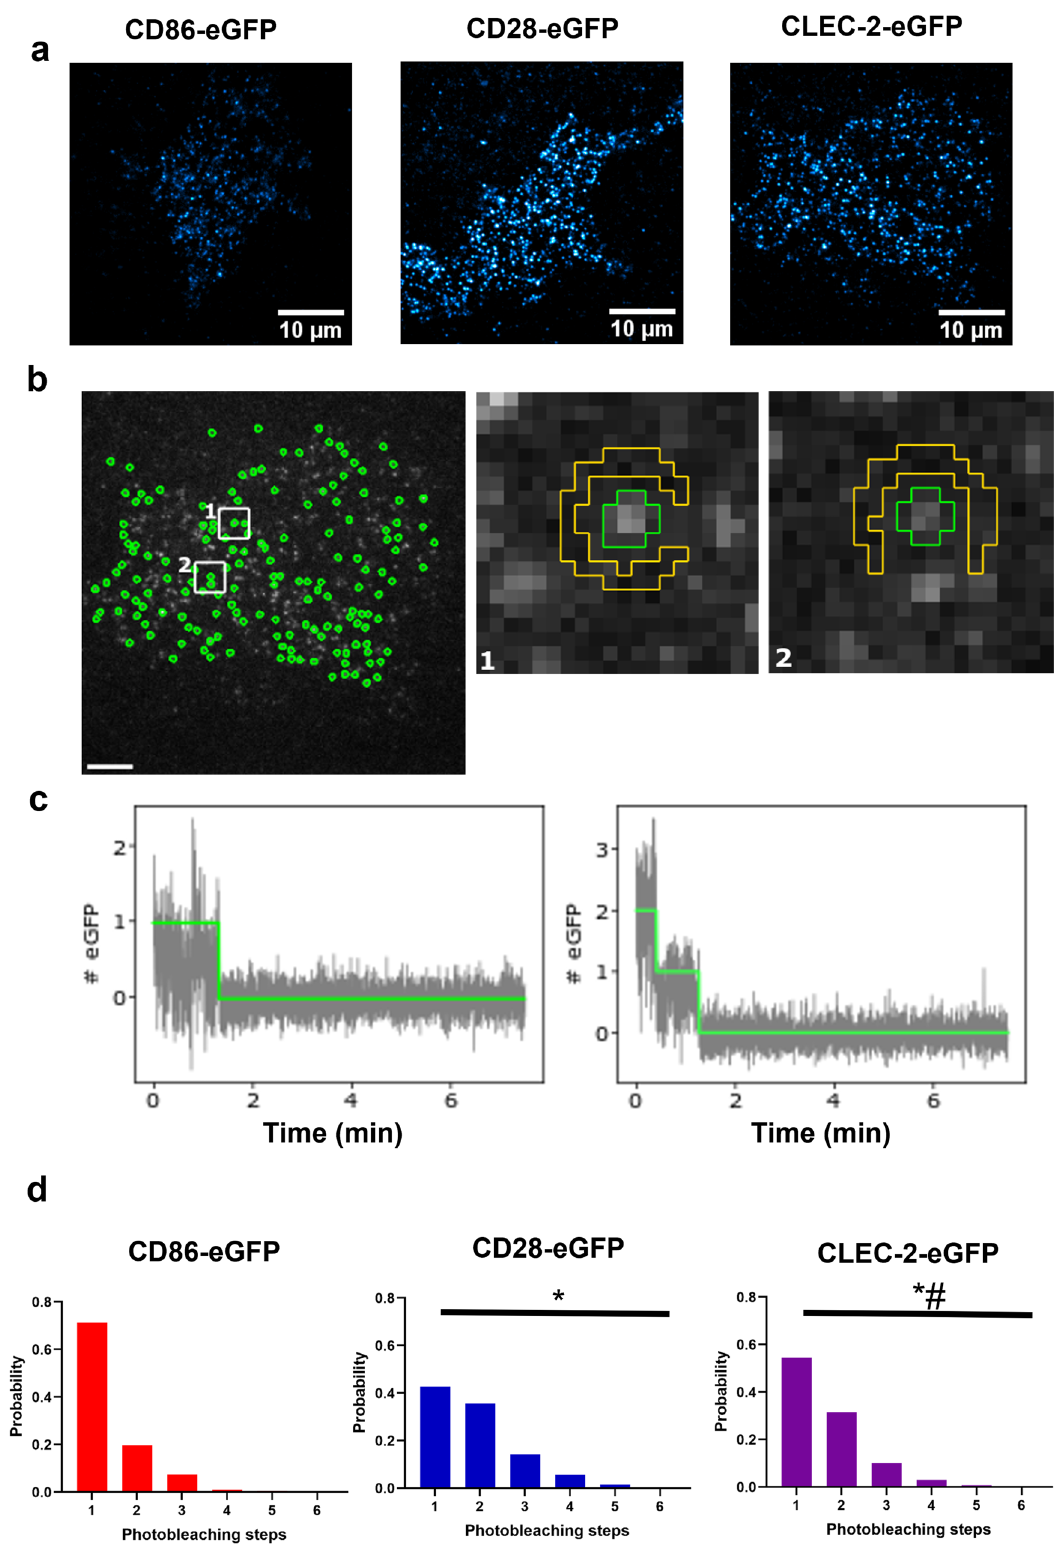
ITAM receptors. Further, we have proposed that CLEC-2 and GPVI function as pattern recognition receptors for a mis- cellaneous group of charged ligands which includes circulating hormones such as adiponectin 53 . The relative insensitivity of human platelets to divalent ligands will also reduce the incidence of activation by this group of